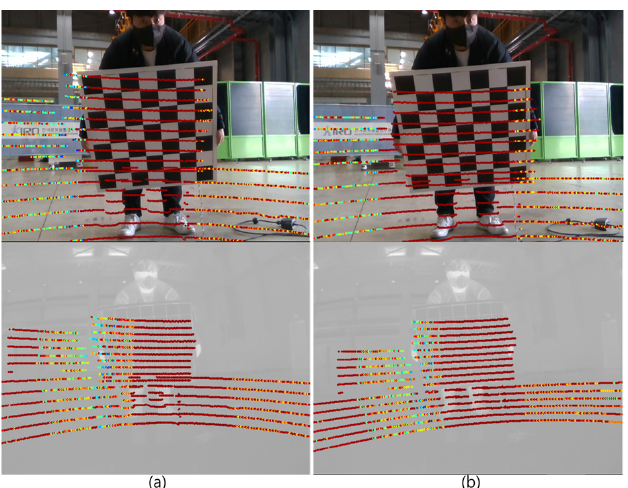
Figure 14. RGB and thermal input images and 3D LiDAR data.